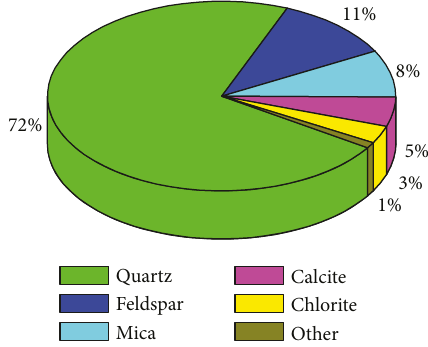
Figure 1: The average mineral composition content of sandstone